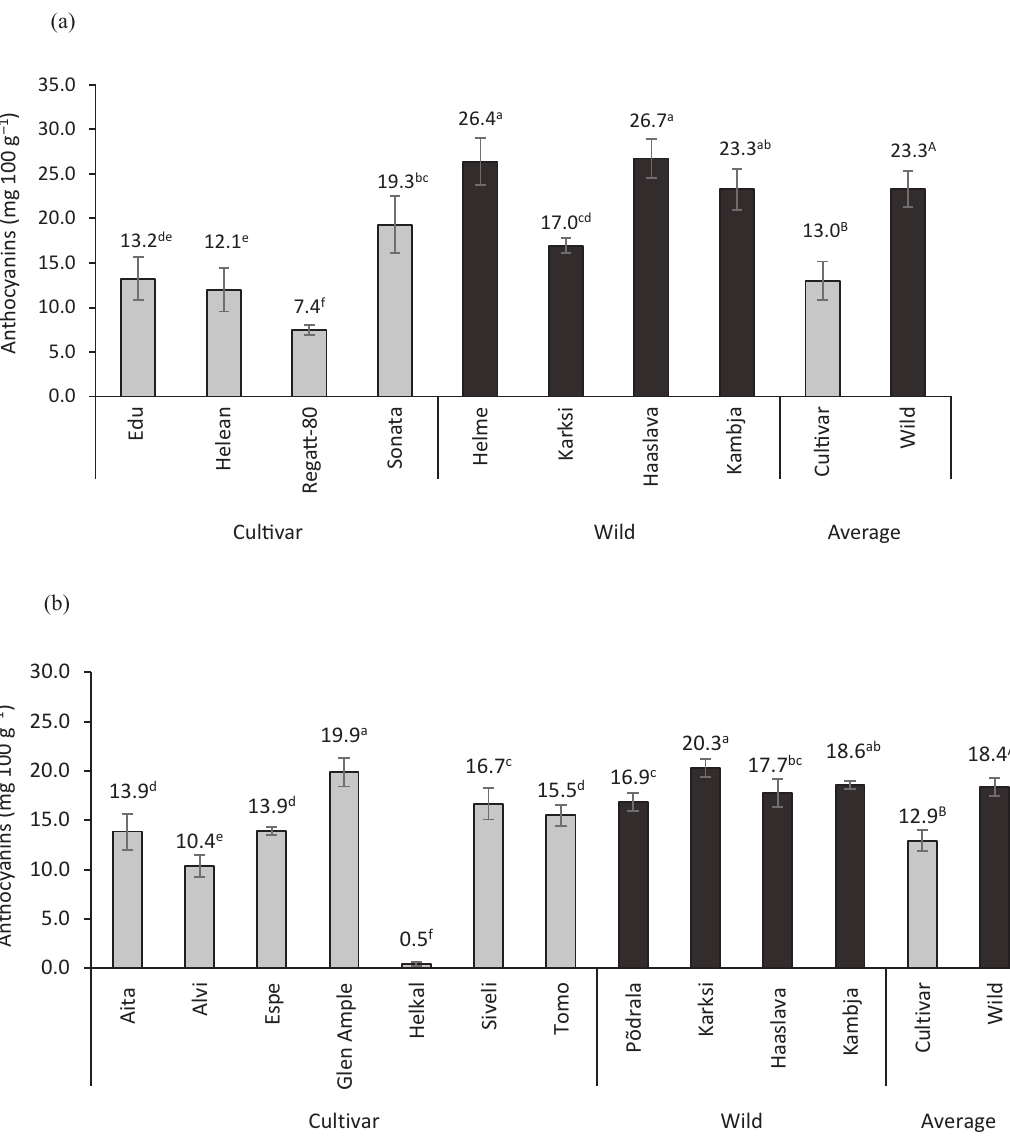
Fig. 1. Anthocyanin content (mean ± standard deviation) of strawberry ( Fragaria × ananassa ) ( a ) and raspberry ( Rubus idaeus ) ( b ) cultivars, wild strawberry ( F. vesca ), and wild raspberry ( R. idaeus ). Different letters (a - f) indicate significant ( p <0.05) difference among all cultivars and wild relatives. Different letters (A, B) indicate significant ( p <0.05) difference between average values of cultivars and wild